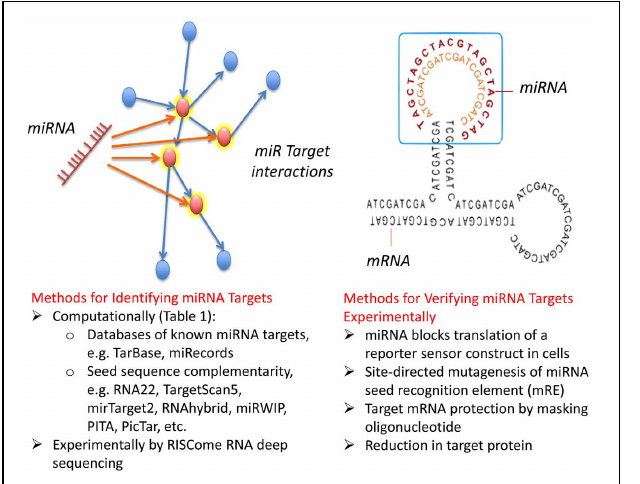
FIGURE 2 | Computational and experimental strategies to identify miRNA targets. miRNAs target multiple proteins, and in certain instances a single family of miRNAs target multiple proteins involved in a common biological process, through imprecise basepairing with recognition sequences in mRNA (see text). Commonly used computational and biochemical approaches to identify targets are summarized along with focused strategies for confirming direct interaction of a miRNA with particular mRNA